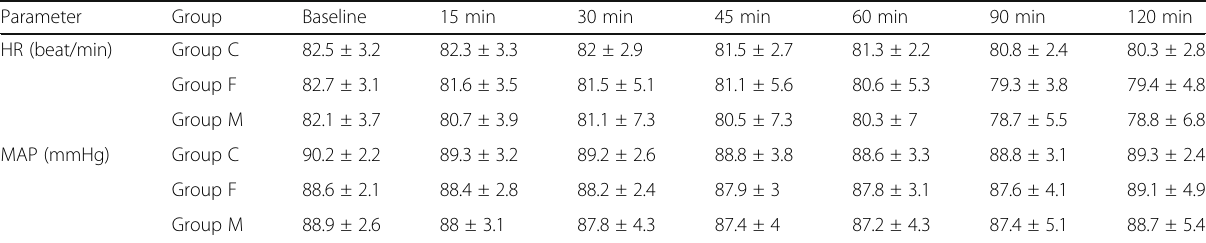
Table 2 Intraoperative hemodynamic variables estimated in studied patients according to injected LAM Parameter